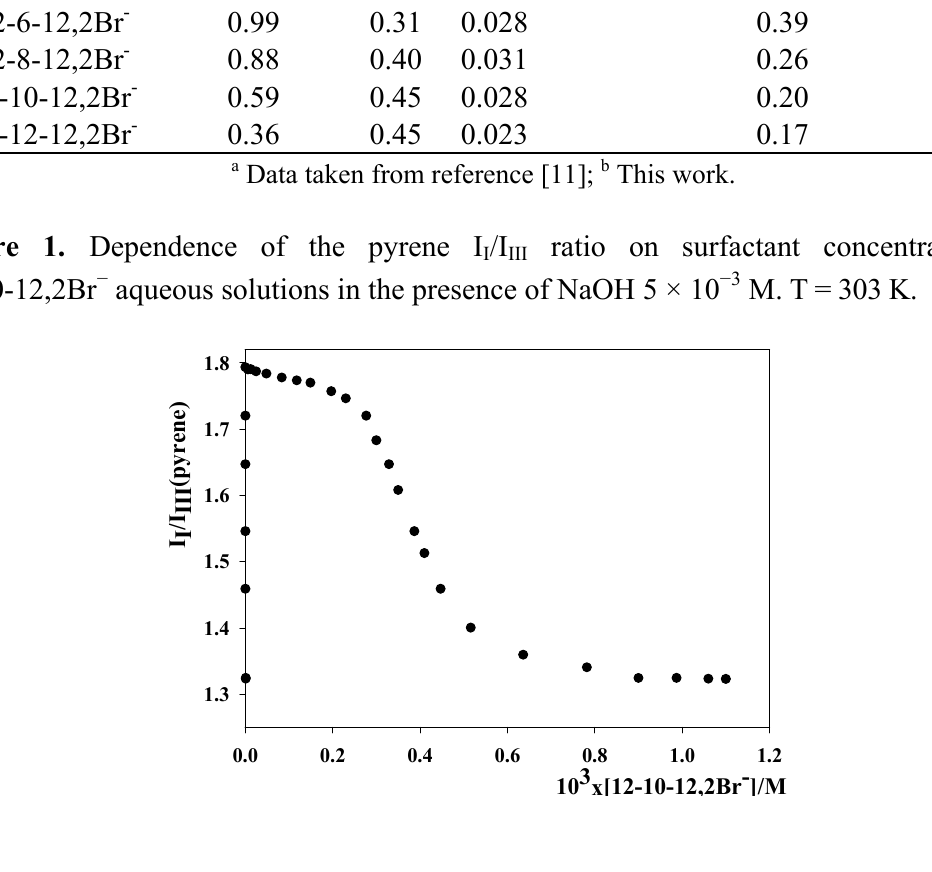
Table 1. Critical micelle concentration, cmc, in the absence and in the presence of NaOH 5 × 10 − 3 M, micellar ionization degrees, α , and second micelle concentrations, C*, for the aqueous dimeric surfactant solutions used as reaction media. T = 303 K.